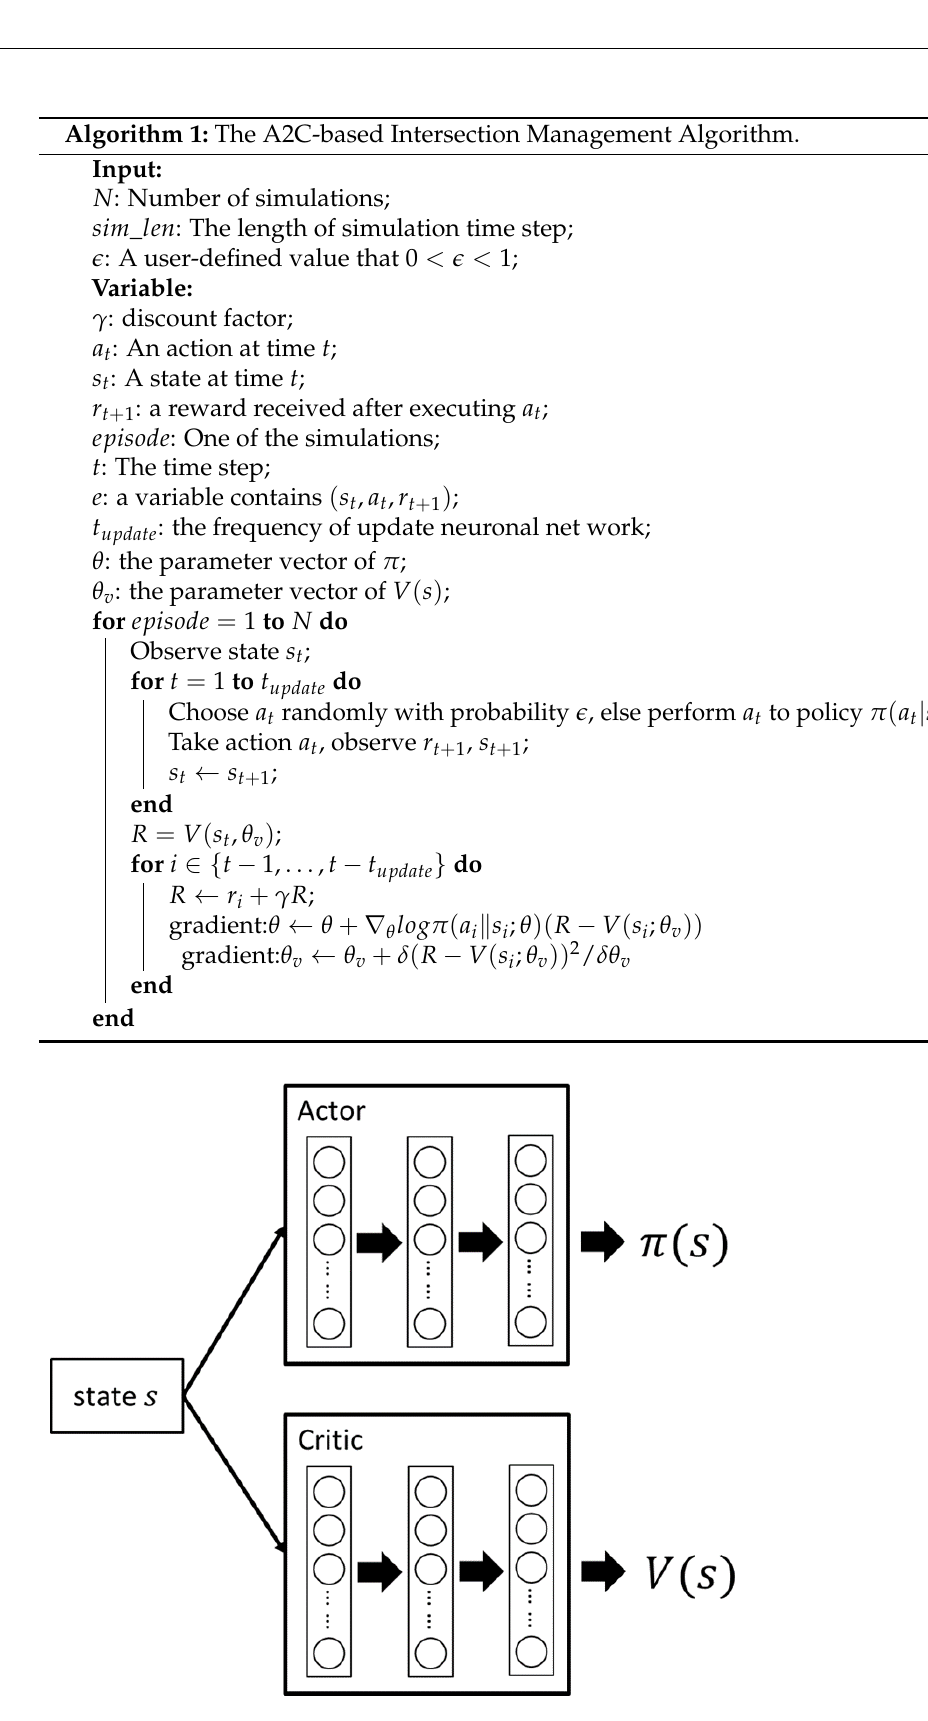
Figure 5. Module Structure of